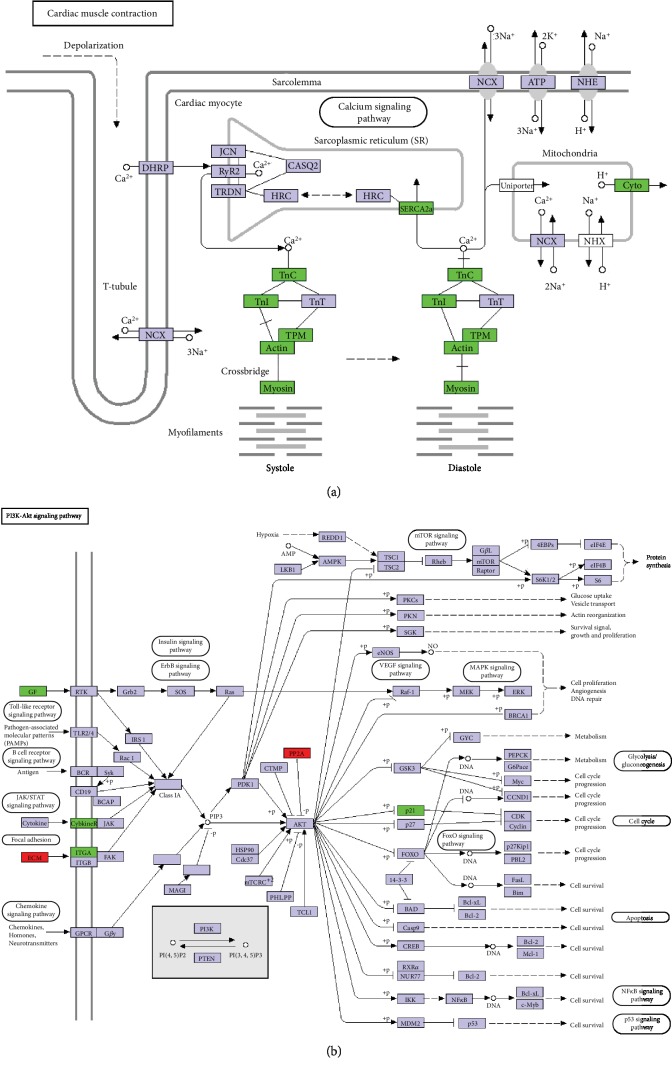
KEGG pathway of cardiac muscle contraction (a) and PI3K-Akt signaling pathway (b). Myofilament is activated by calcium and bind to troponin C. Troponin combines with tropomyosin and actin through the inhibitory protein troponin I without calcium.